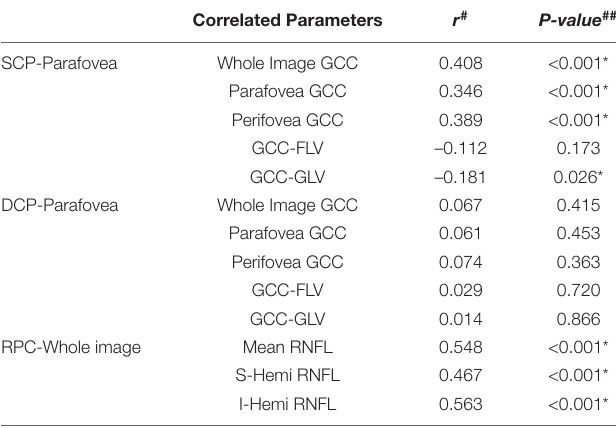
TABLE 3 | The correlation between microvascular parameters and neural parameters. Correlated